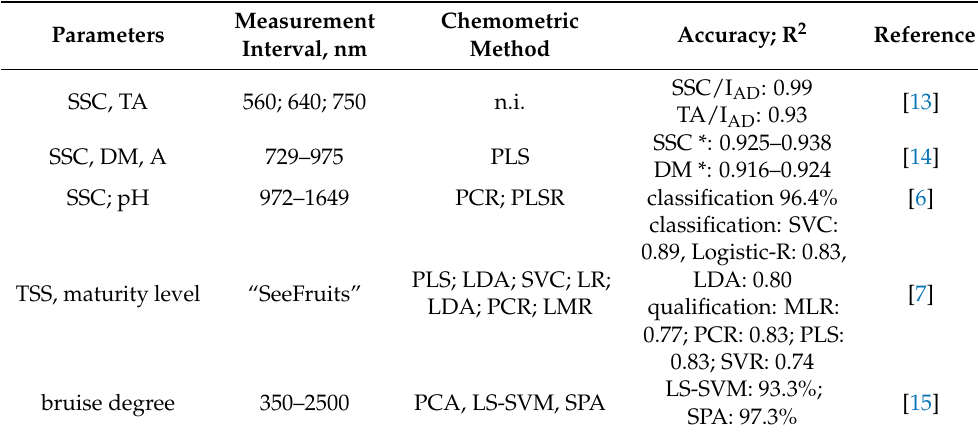
Table 1. Summary of previous works dealing with the NIR analysis of cherry